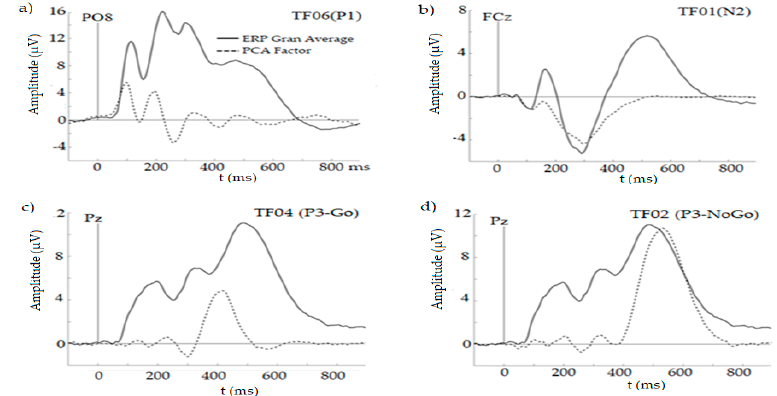
Figure 2. Graphical plots of the main ERP components identified: ( a ) TF01, P1; ( b ) TF01, N2, ( c ) TF04, P3-Go, ( d ) TF02, P3-NoGo, Grand average (solid line) versus PCA factor (dashed line) is shown for each component at the location of the maximum peak.